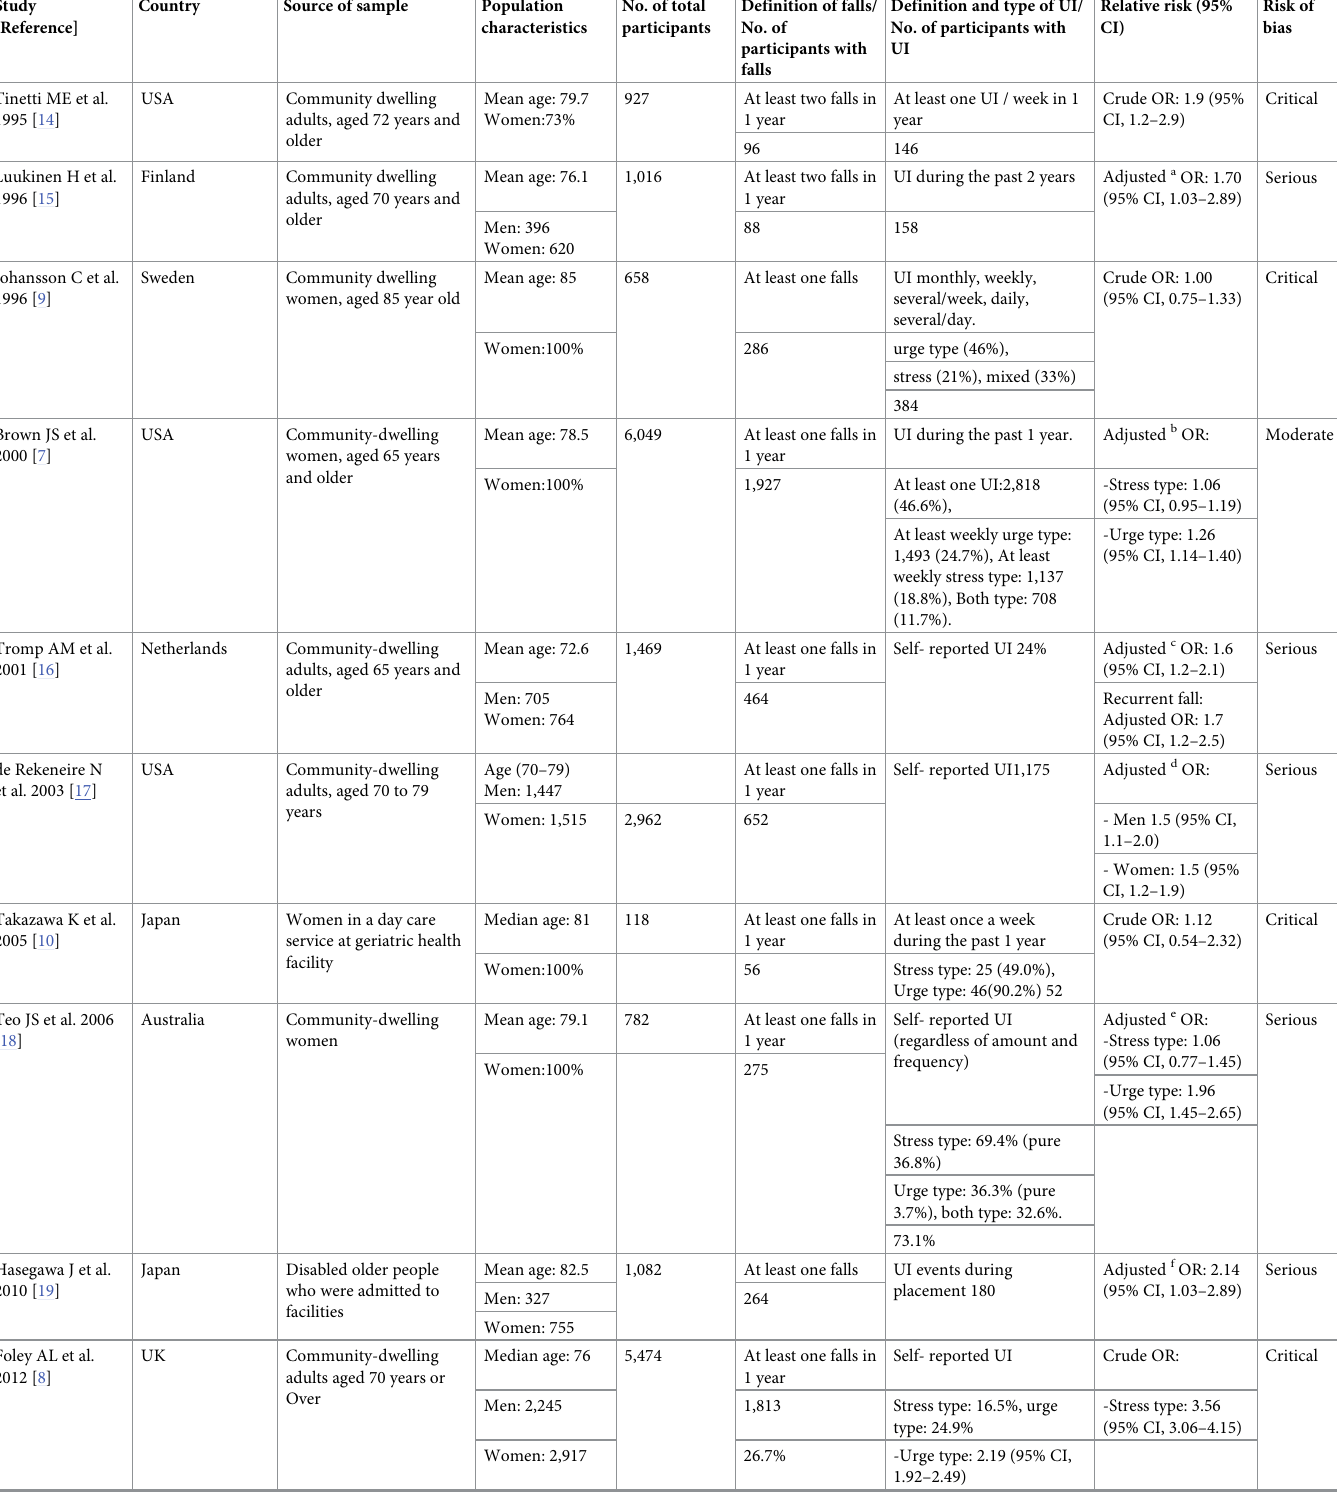
Table 1. Summary of the 38 studies included in the present